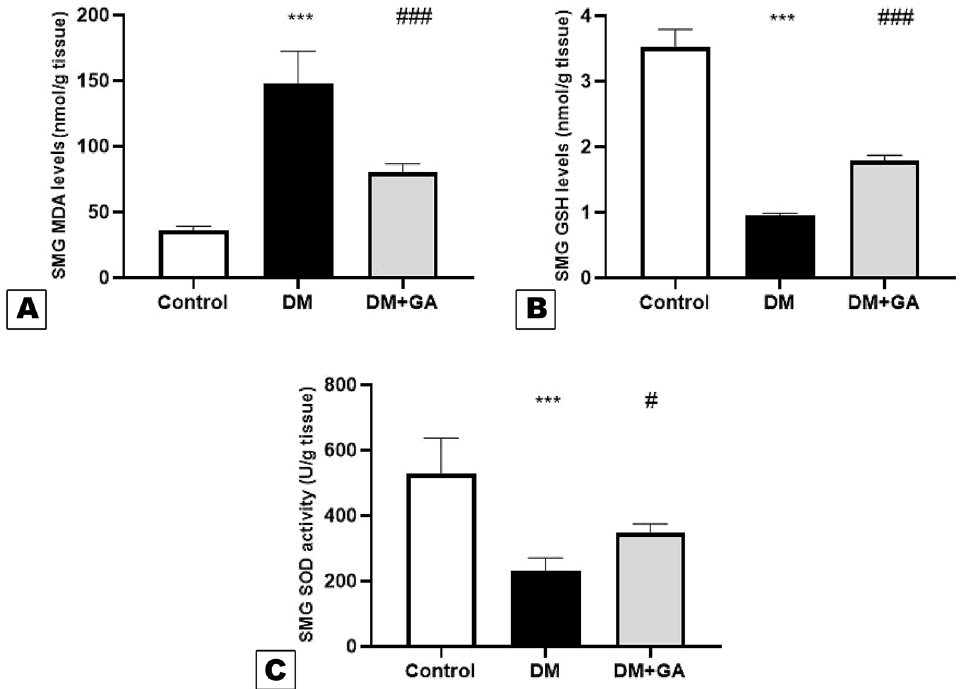
Figure 2. Effect of GA treatment on oxidative stress markers in SMG of diabetic rats. ( A ) MDA, ( B ) GSH and ( C ) SOD. Data were expressed as mean ± SE. P < 0.05 was considered significant. ***Significant compared to control group at P < 0.001, # Significant compared to diabetic group at P < 0.05, ### Significant compared to diabetic group at P <